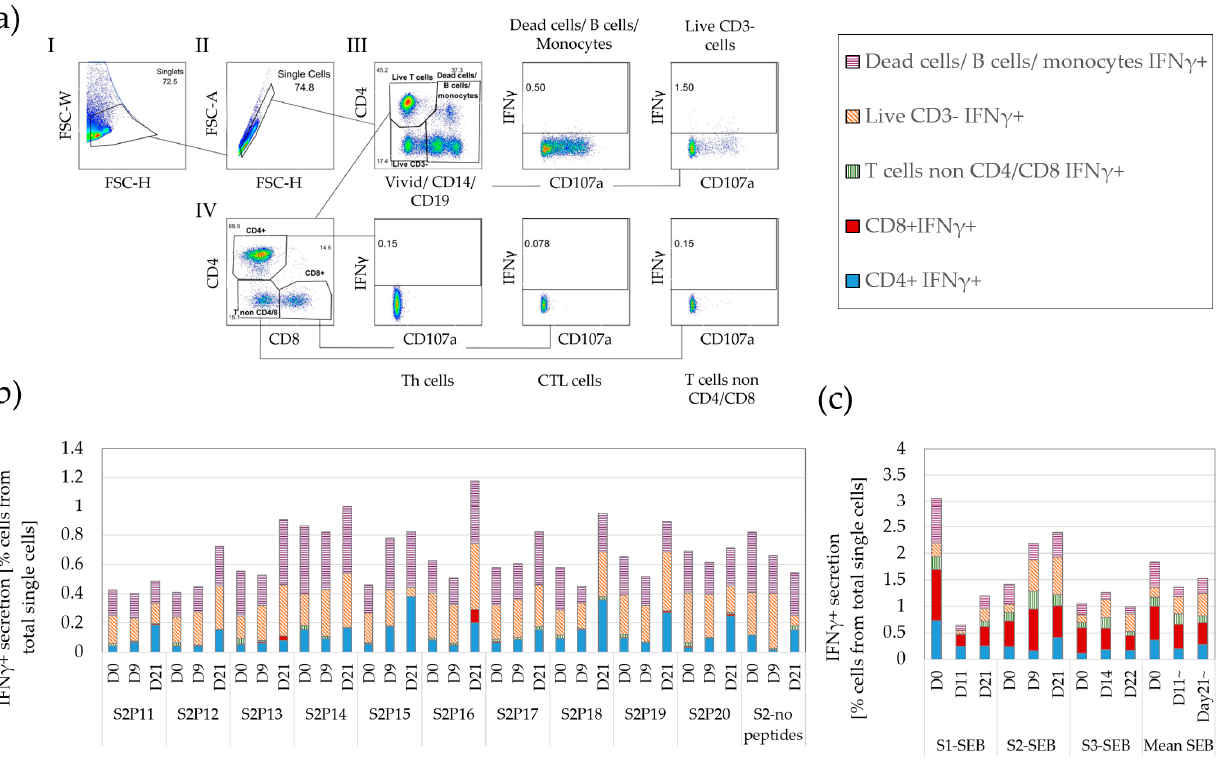
Figure 1. Vaccination-targeted and -untargeted secretion of IFN γ in ELISpot-like flow cytometry (ELF): PBMC from a glioma patient were cultured with or without tumor-specific peptides overnight and stained with a full FCM panel (see text). ( a ) Gating strategy of IFN γ secretion to tumor-specific peptides. The cells were analyzed by FCM and serially gated for (I+II) non-doublet/clumped single-cell gates; (III) live T cells (using a wide gate to include all activated T cells), live CD3- cells, and B cells / monocytes /dead cells (on a single dump channel); (IV) grouping into CD4+/ CD8+/ CD4-CD8- T cells. All cell populations were then gated for IFN γ secretion. Repeated 6 times using different sample sets. ( b ) Total IFN γ secretion to peptides (P11–20) in vaccine Set2 (S2) displayed by the cell subsets secreting IFN γ . ( c ) IFN γ secretion in response to SEB displayed by the cell subsets secreting IFN γ .